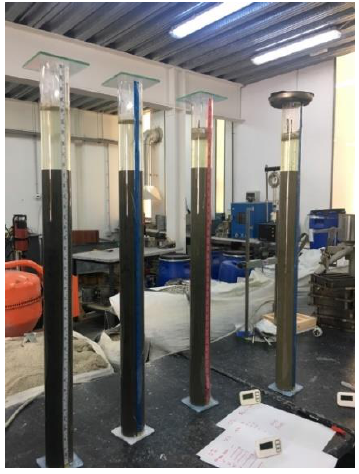
Figure 5. Exudation test.